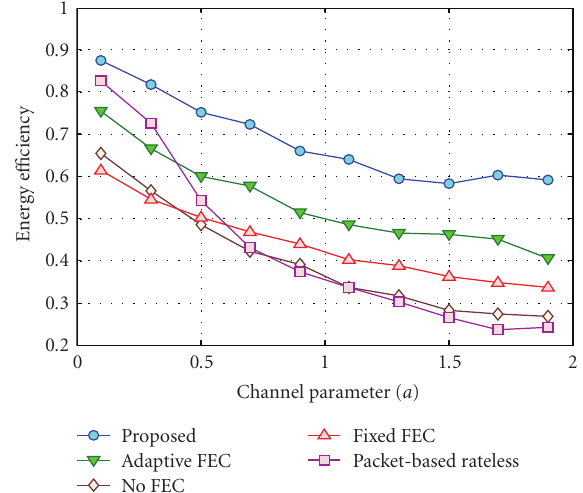
Figure 8: Comparison of energy e ffi ciency for block-based rateless coding and various FEC-bearing streams with competing biosensor tra ffi c, for varying duration (indexed by a ) of bad state in a two- state Rayleigh